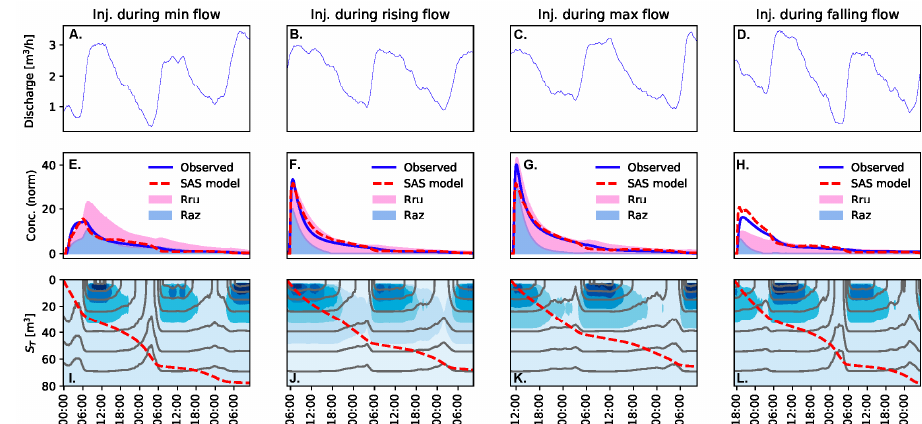
Figure 3. Time-series of discharge (panels A – D ), observed and simulated concentration normalized by input mass (panels E – H ), and density of the SAS function (panels I – L ; darker color indicates higher probability). A vertical section along the bottom row can be interpreted as a probability density function of the age-ranked storage being exported from the study reach at any given time step.